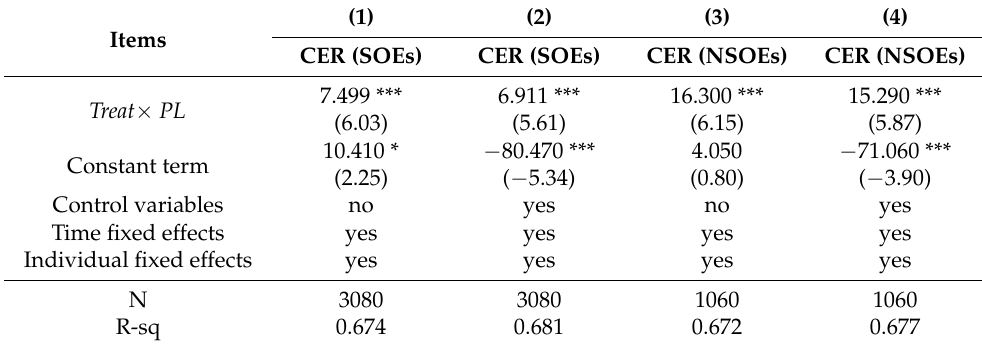
Table 9. Estimation results of different property rights